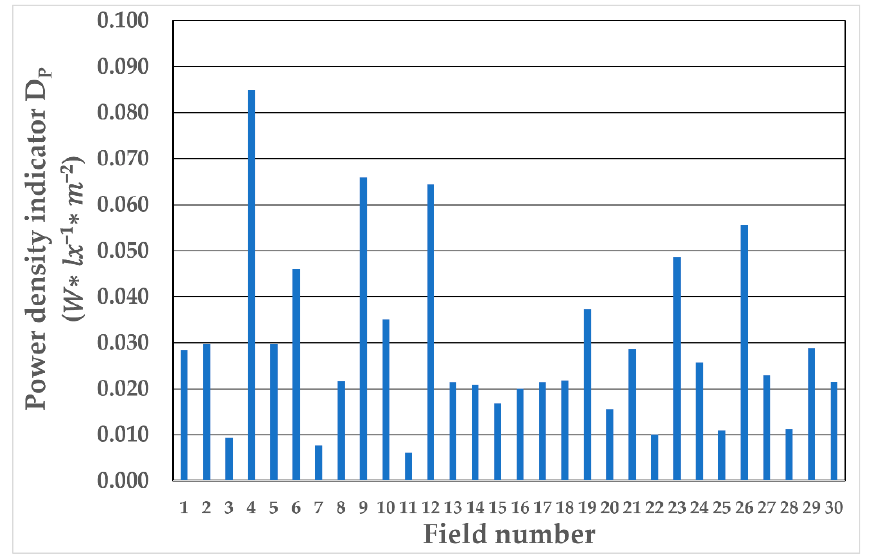
Figure 13. Power density indicator D P ( W ∗ lx (cid:2879)(cid:2869) ∗ m (cid:2879)(cid:2870) ) in the calculation field.